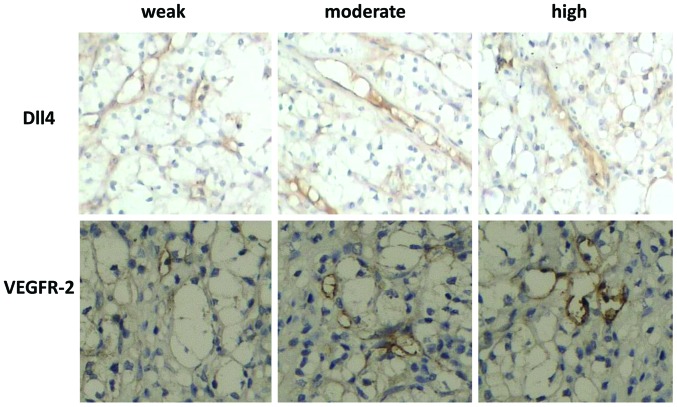
Immunohistochemical staining for delta-like ligand 4 (Dll4) and vascular endothelial growth factor receptor 2 (VEGFR-2) in clear cell renal cell carcinoma (CCRCC). Dll4 was mainly expressed in the tumor vasculature, and VEGFR-2 was mainly expressed in the tumor vasculature and the cytoplasm. Weak Dll4 expression (score 1), moderate Dll4 expression (score 4) and (high Dll4 expression (score 6) in CCRCC. Weak VEGFR-2 expression (score 1), moderate VEGFR-2 expression (score 4) and high VEGFR-2 expression (score 6) in CCRCC. Original magnification, ×200.